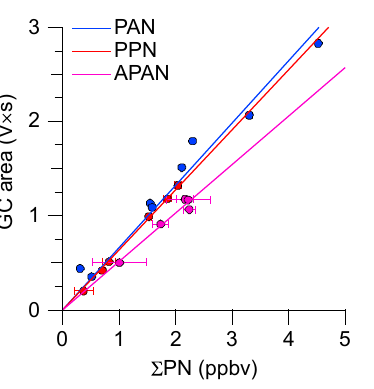
Figure A2. PAN-GC calibration plots for PAN, PPN, and APAN (post-FOSSILS).